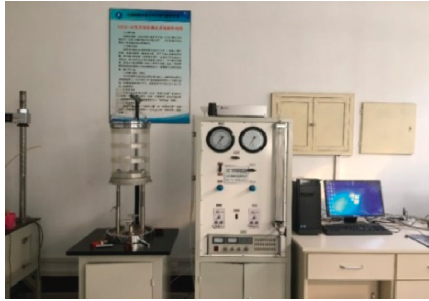
Figure 3: Resonant column apparatus (GZZ-50).